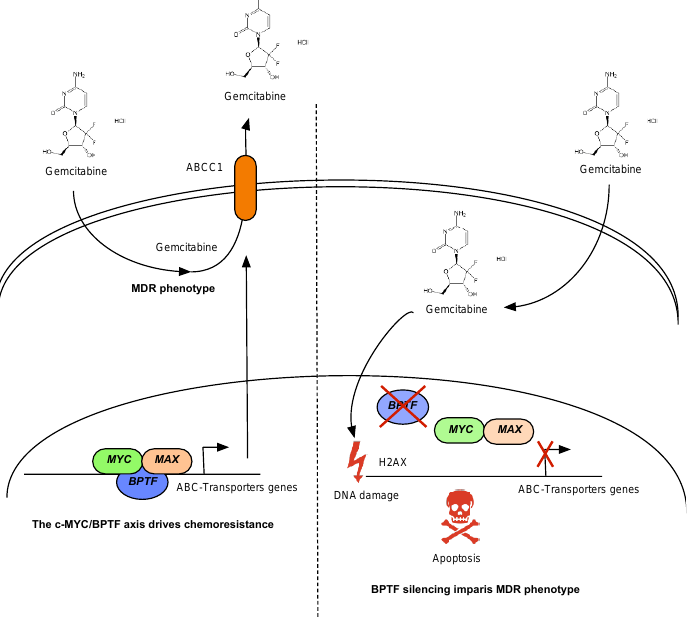
Figure 7. Schematic model of the synergism between BPTF-silencing and gemcitabine action. BPTF drives the expression of ABC-transporters in a c-MYC-dependent manner. BPTF inhibition impairs the c-MYC-dependent transcription of different ABC-transporters, avoiding the MDR phenotype and increasing DNA damage.